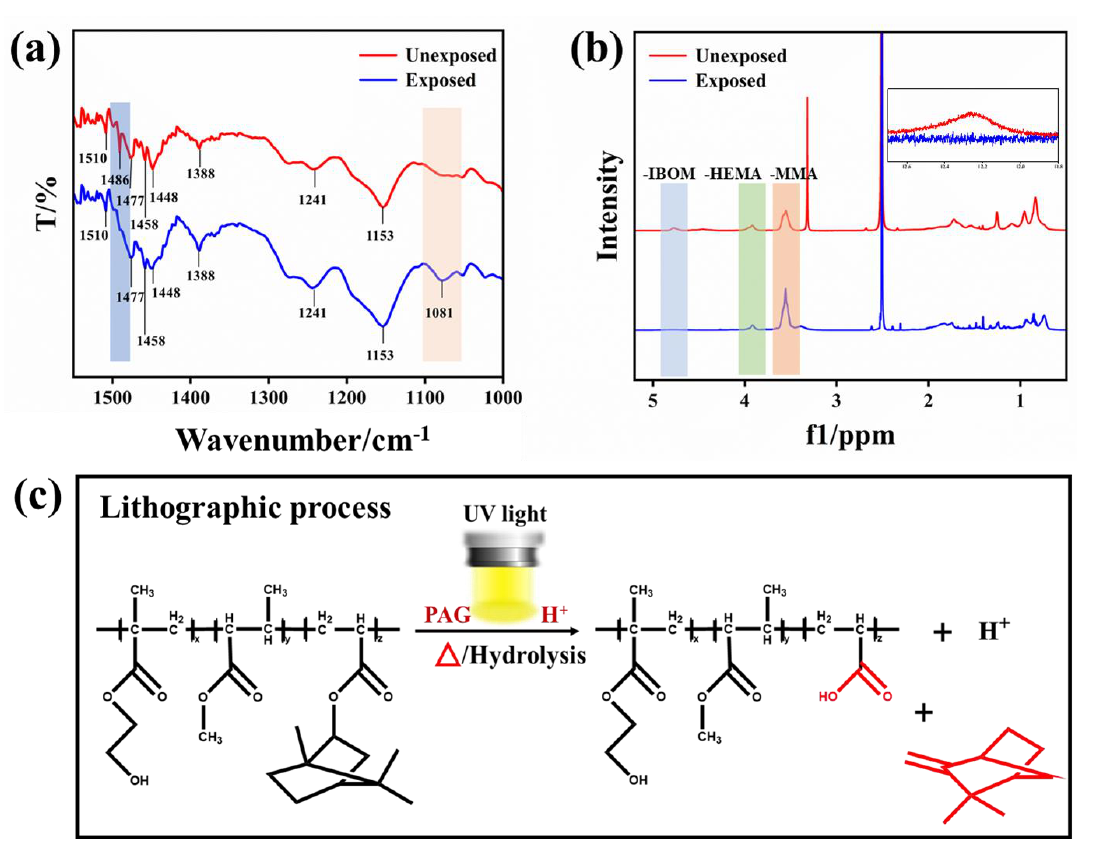
Figure 7. Structural changes before and after exposure: ( a ) FT−IR; ( b ) 1 H−NMR spectra; and ( c ) the lithographic process.